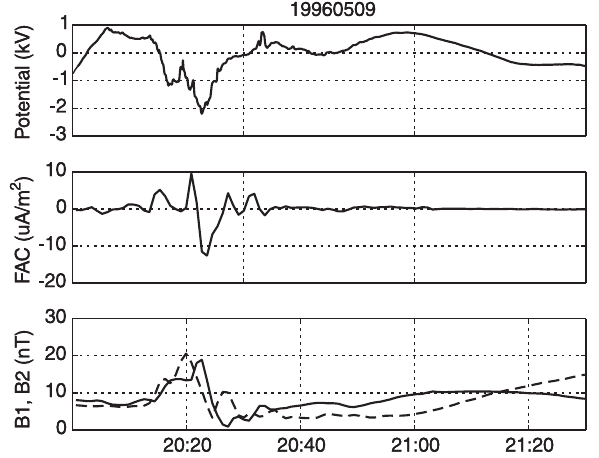
Fig. 5. Event 960509 20:15–20:30 UT. Since B 2 (cid:24) B 1 , the FAC is not very reliable. As the potential and the FAC are both negative, this could support the upward extended U-shaped potential, but the magnitude of the potential is not very large. Among our 78 events this is one of the two that are somewhat compatible with the upward extended U-shaped potential picture